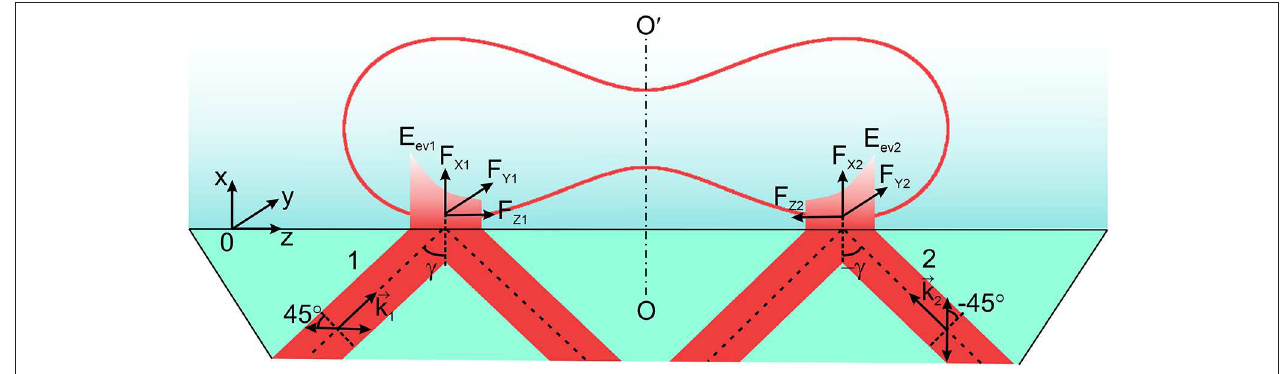
FIGURE 4 | Two linearly polarized beams 1 and 2 with azimuths of polarization γ ). Here E k 1 , E k 2 are the wavevectors of the incident beams; F X 1 , F X 2 , F Y 1 , F Y 2 , F Z 1 , F Z 2 are the components of the optical force of the evanescent waves E ev 1 and ( ± E ev 2 . OO ′ is the axis of symmetry of an erythrocyte.